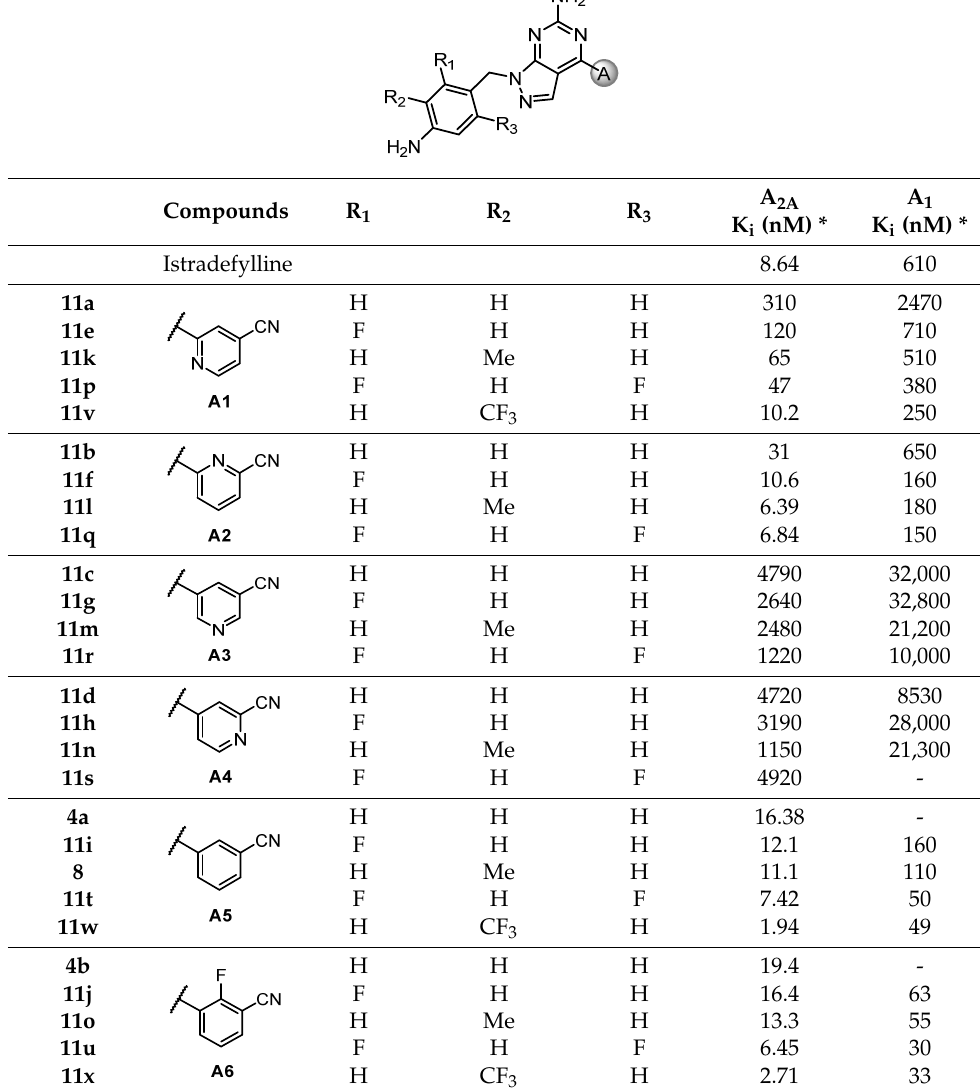
Table 1. Binding affinity of synthesized compounds for h A 2A receptors.